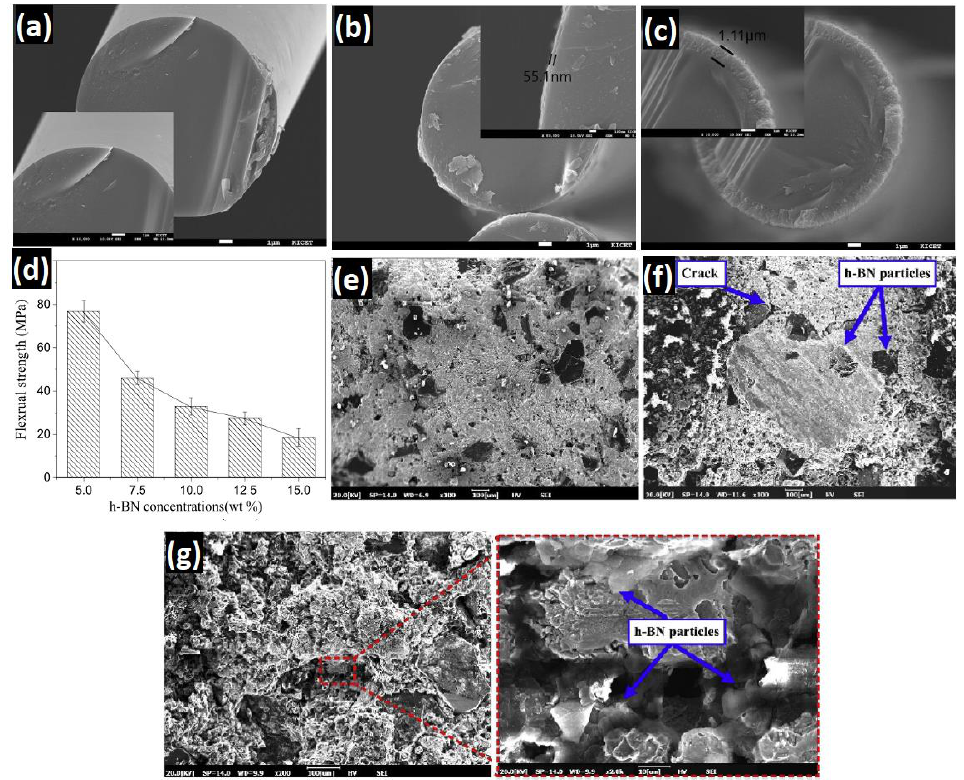
Figure 17. Morphology of fiber at reaction temperatures of graphene oxide to boron nitride: ( a ) 1200 °C, ( b ) 1300 °C and ( c ) 1400 °C (Reprinted with permission from Springer, Copyrights 2020) [144]. ( d ) Friction coefficient versus h-BN concentrations; SEM images of the worn surface of composites after testing with different h-BN amount, namely, ( e ) 5, ( f ) 10 and ( g ) 15 wt.% (Reprinted with permission from Elsevier, Copyrights 2020) [145].